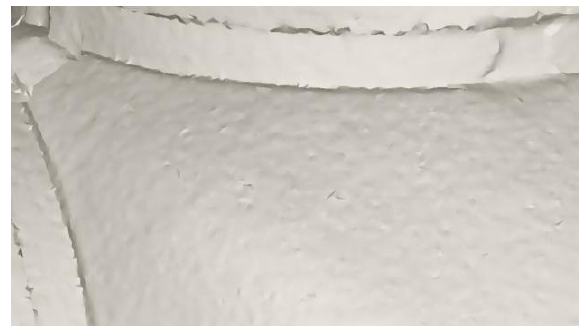
section profiles obtained from image-matched meshes (MicMac processing in orange and PhotoScan processing in blue), the profile from the laser scanner survey (in pink) and the graphs of radiometric values coinciding with the selected sections of the images (Figures Figure 12 - Detail of a corner of the PhotoScan model of the central vault